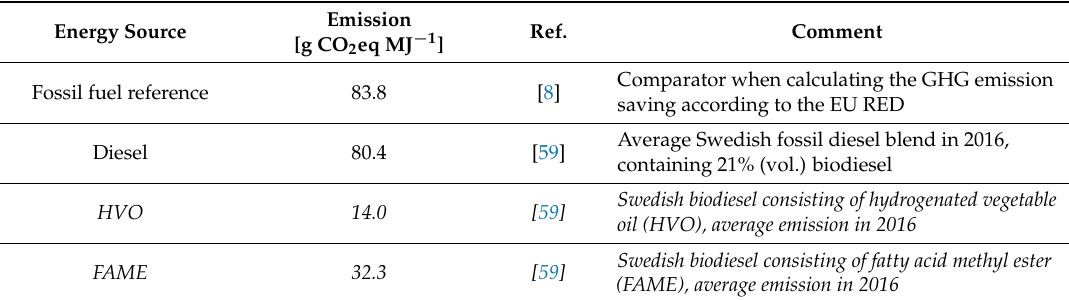
Table A15. Emissions resulting from energy input. Values in italics are alternative values used in sensitivity analysis. All other values were those used in the base case (values refer to the lower heating values for